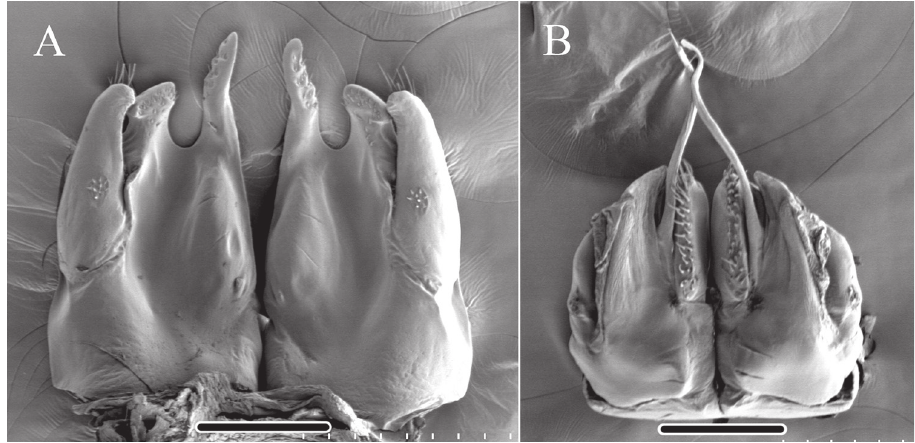
Figure 15. Glyphiulus guangnanensis sp. n., paratype. A anterior gonopods, caudal view B posterior gonopods, caudal view. Scale bars: A, B 0.2